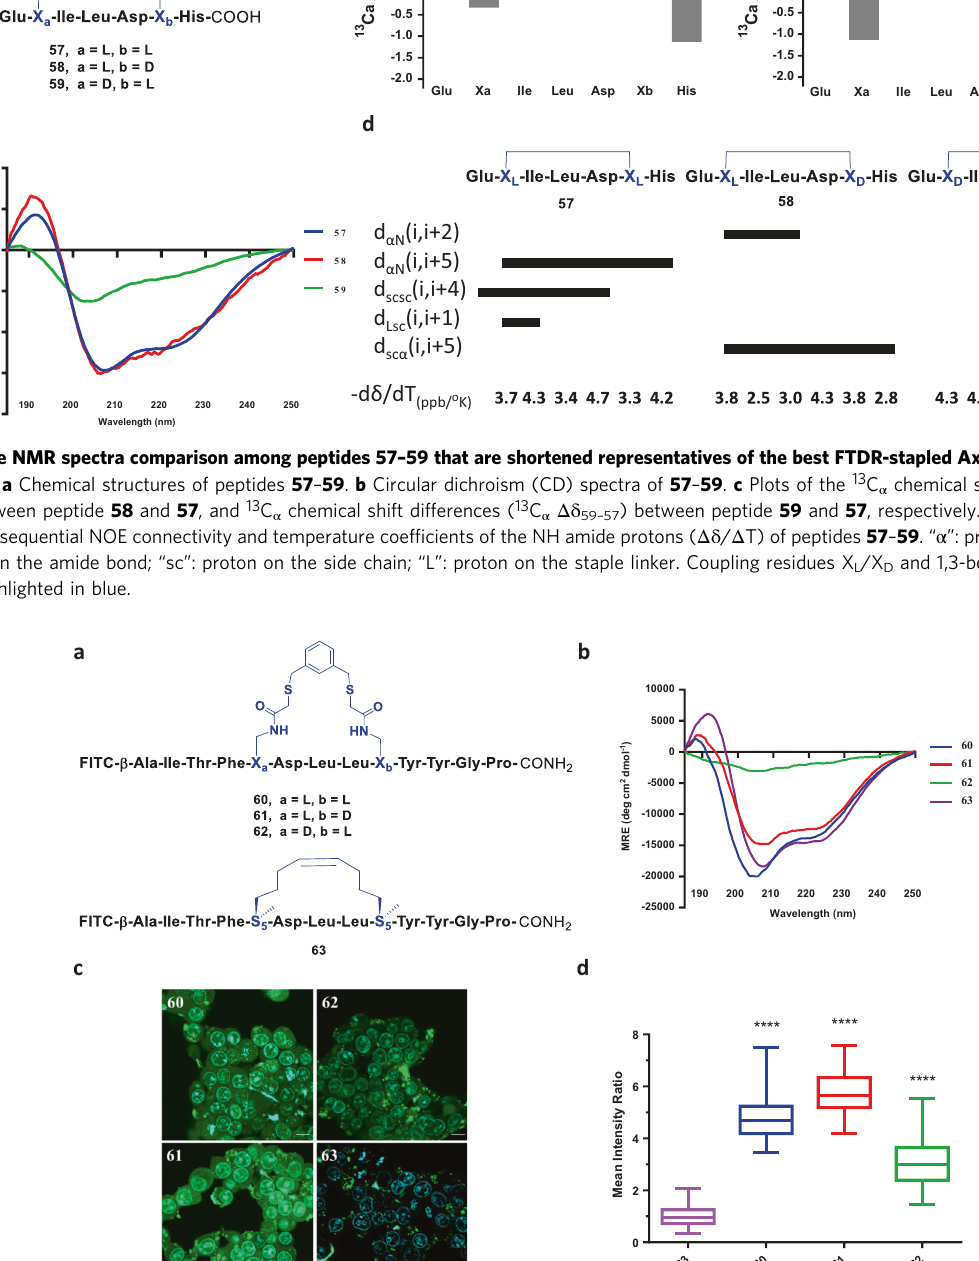
NATURE COMMUNICATIONS| (2022) 13:350